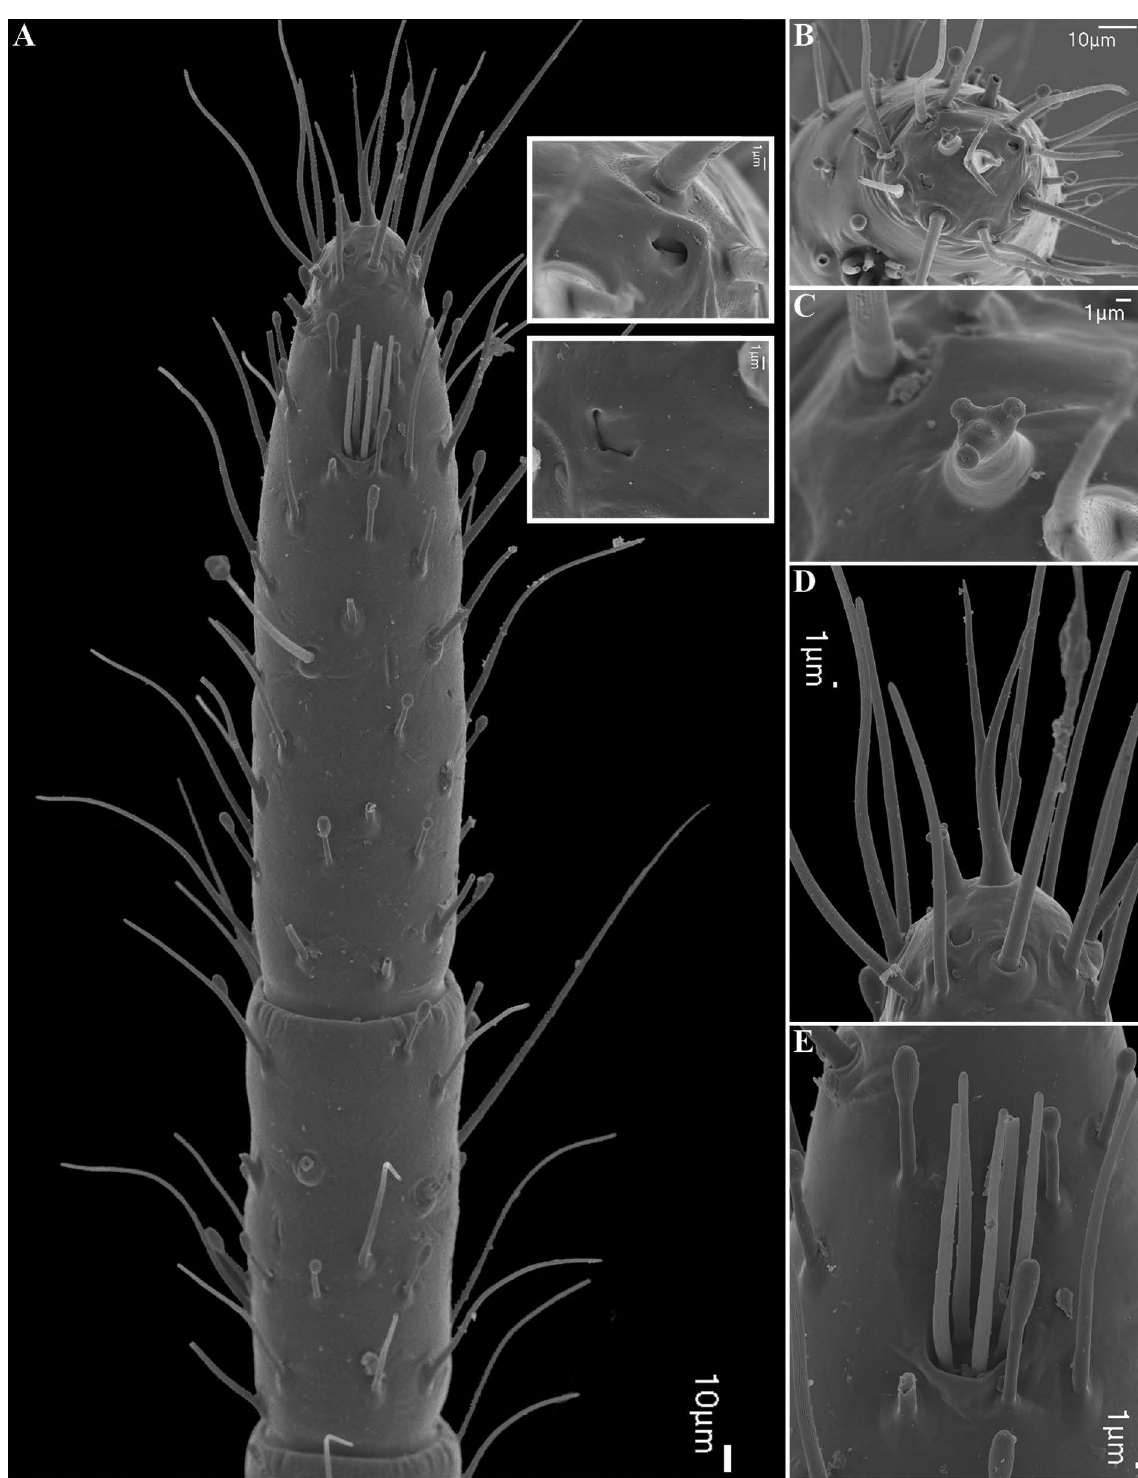
Fig. 124. Sarax rimosus (Simon, 1901) (AMCC [LP 11996]), antenniform leg I, ♀. A . Distal article of tarsus, lateral view. Insets: slit sensillae. B . Distal article of tarsus, frontal view. C . Tarsal organ near tarsal claw. D . Tarsal claw, lateral view. E . Rod sensilla and olfactory